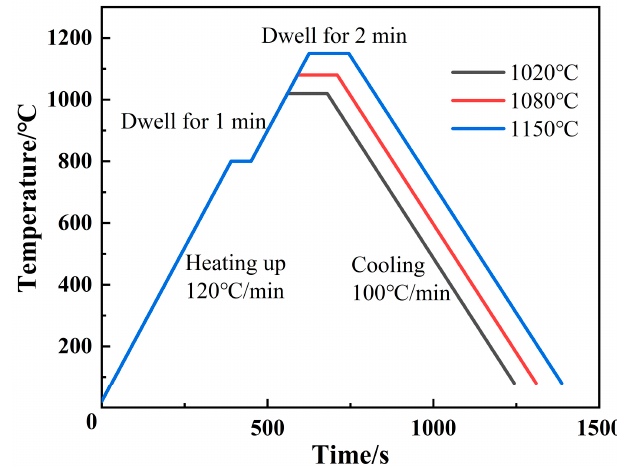
Figure 2. Temperature profile for wetting tests.